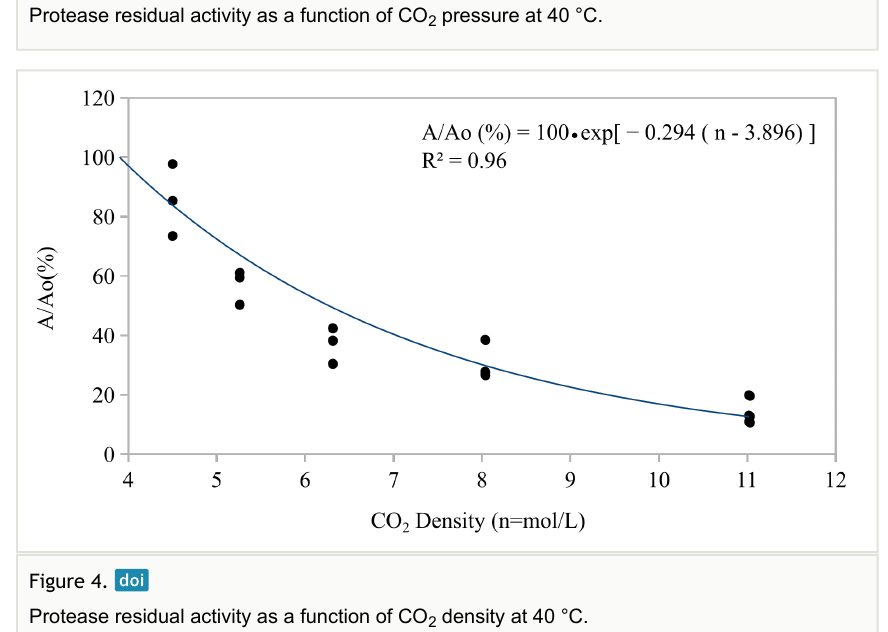
Figure 3. Protease residual activity as a function of CO pressure at 40 °C. 2